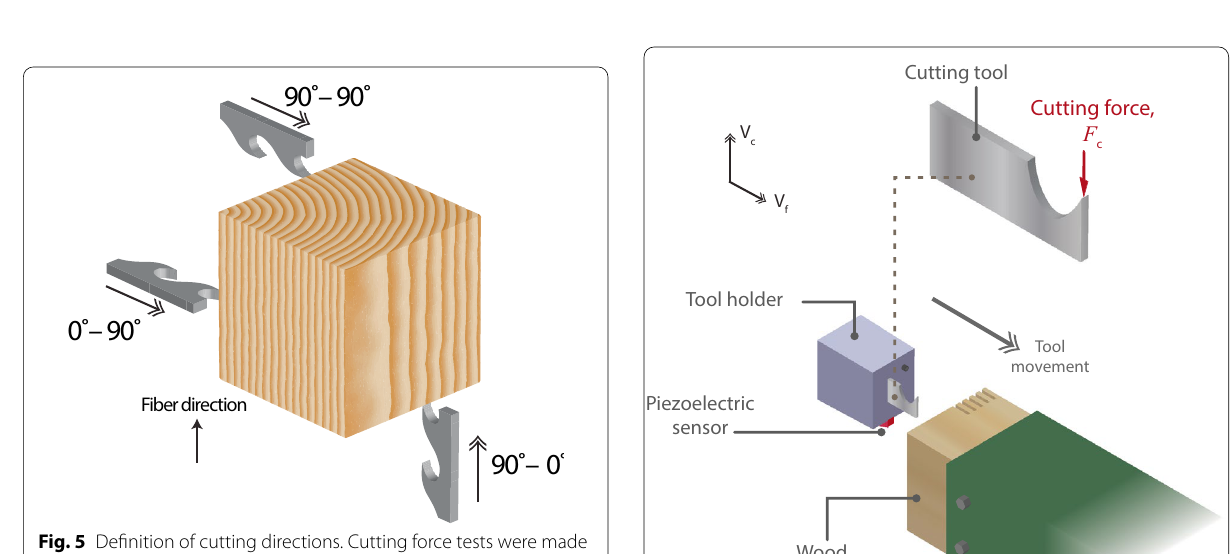
Bold-italic values indicate changed parameter values